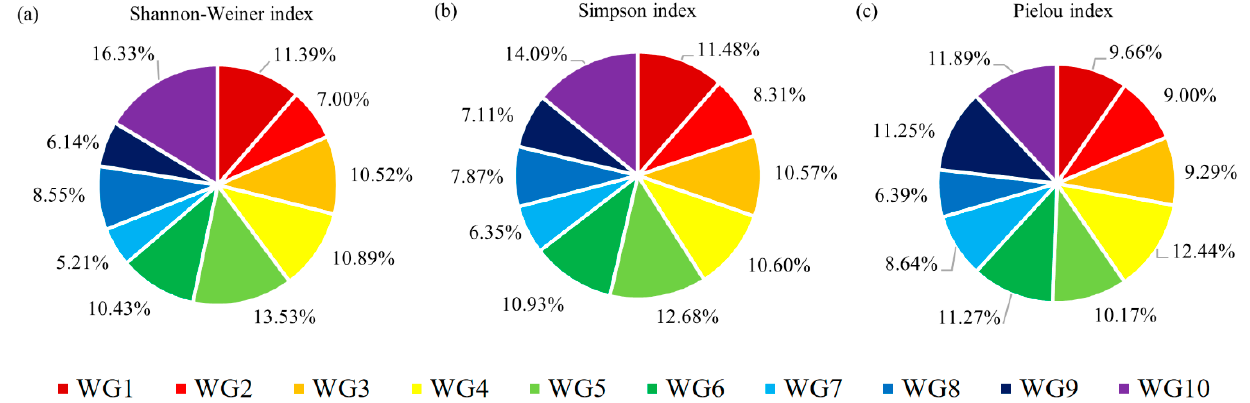
Figure 3. The ( a – c ) show the Shannon–Weiner index, Simpson index, and Pielou index characteristic of 10 monitoring wells, respectively.